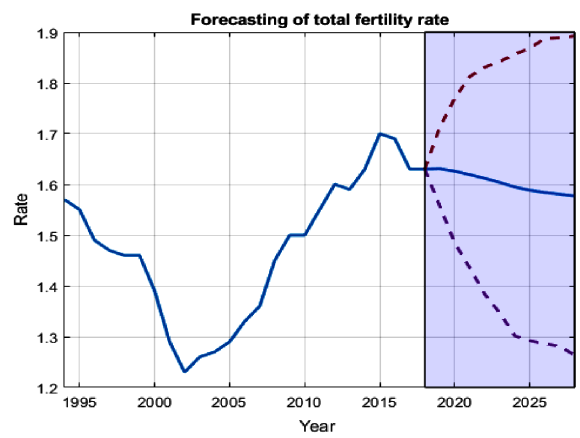
Figure 6. History and forecasting of the total fertility rate (source: authors’ calculations)